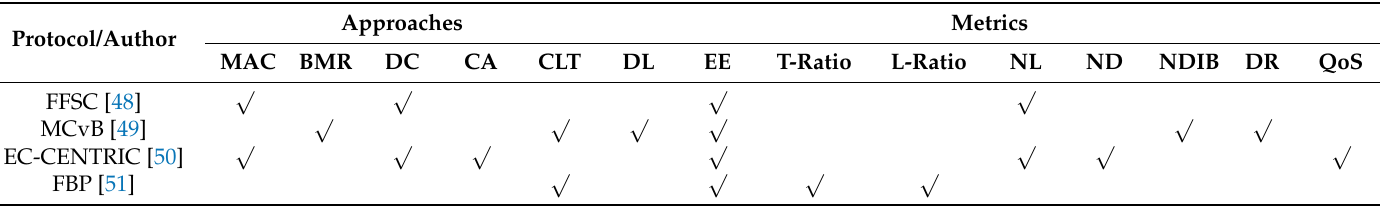
Table 13. Comparative assessment of energy efficient communication